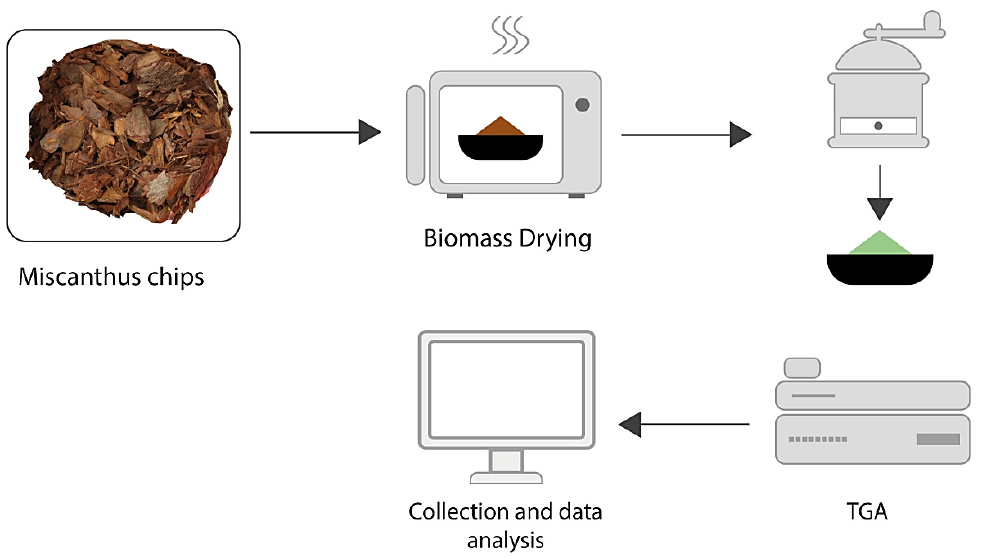
Figure 18. Set-up for a Miscanthus torrefaction process for the production of carbonized solid material and biocarbon as carriers for bio-fertilizers.